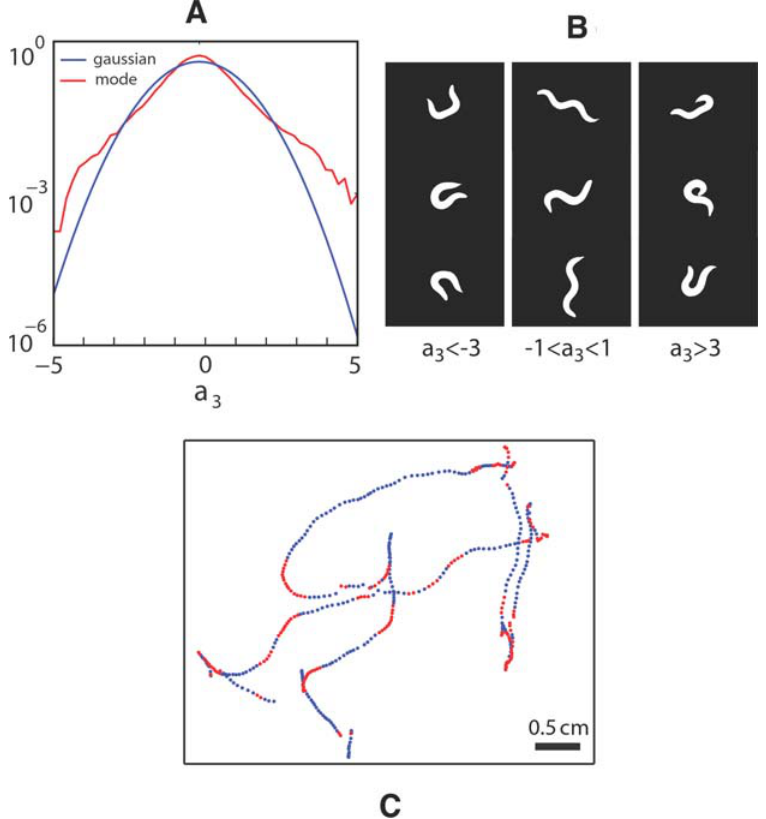
Figure 4. Motions along the third eigenworm. (A) The distribution of amplitudes r ( a 3 ), shown on a logarithmic scale. Units are such that T ~ 1 , and for comparison we show the Gaussian distribution; note the longer tails in r ( a 3 ). (B) Images of worms with values of a 3 in the negative S a 2 3 tail (left), the middle (center) and positive tail (right). Large negative and positive amplitudes of a 3 correspond to bends in the dorsal and ventral direction, respectively. (C) A two minute trajectory of the center of mass sampled at 4 Hz. Periods where | a 3 | . 1 are colored red, illustrating the association between turning and large displacements along this mode.